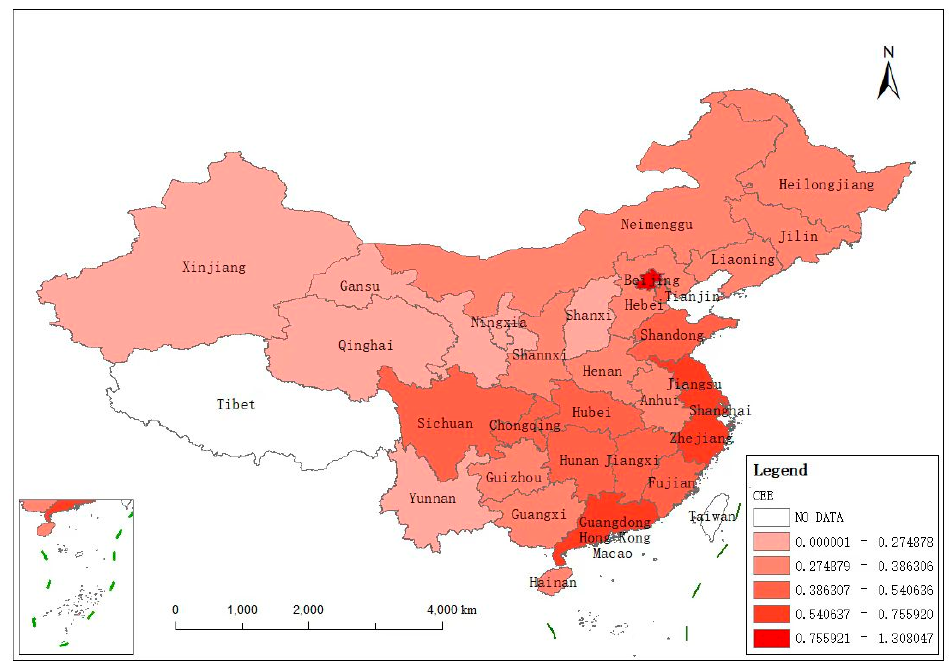
Figure 2. The average carbon emission efficiency (ACEE) in different Chinese provinces from 2016 to 2019.